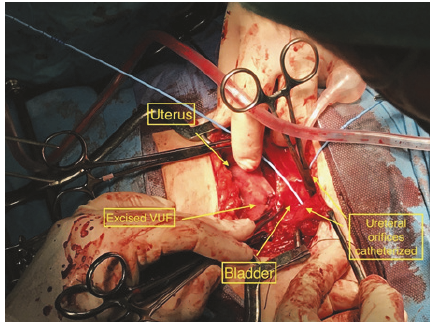
Figure 4: Intraoperative view of uterus, bladder, excised VUF tract, and catheterized ureteral orifices with ureteral stents left for cutaneous